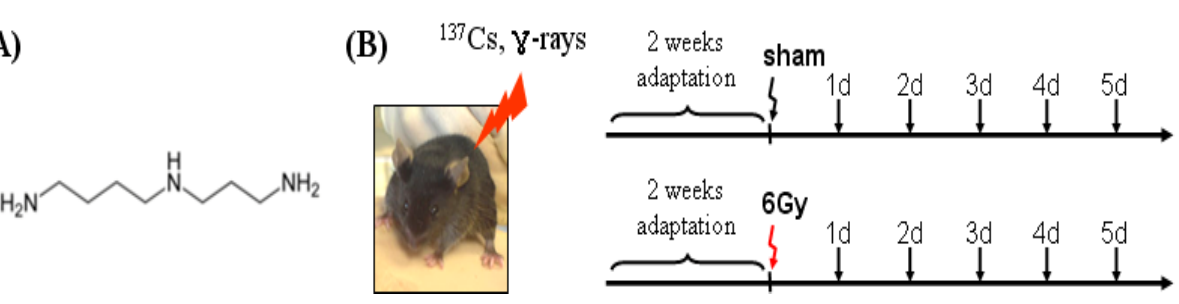
Figure 1. The chemical structure of spermidine ( A ) and experimental design of the mouse (C57BL/6) model response to ionizing radiation ( B